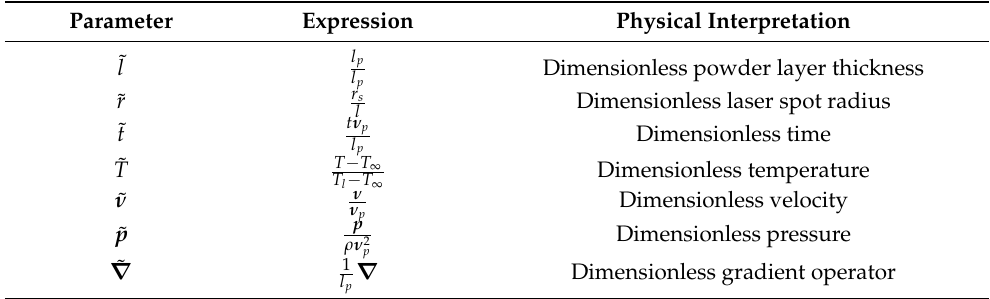
Table 1. List of the scaling variables used in the non-dimensionalization of Equations (4) and (5).